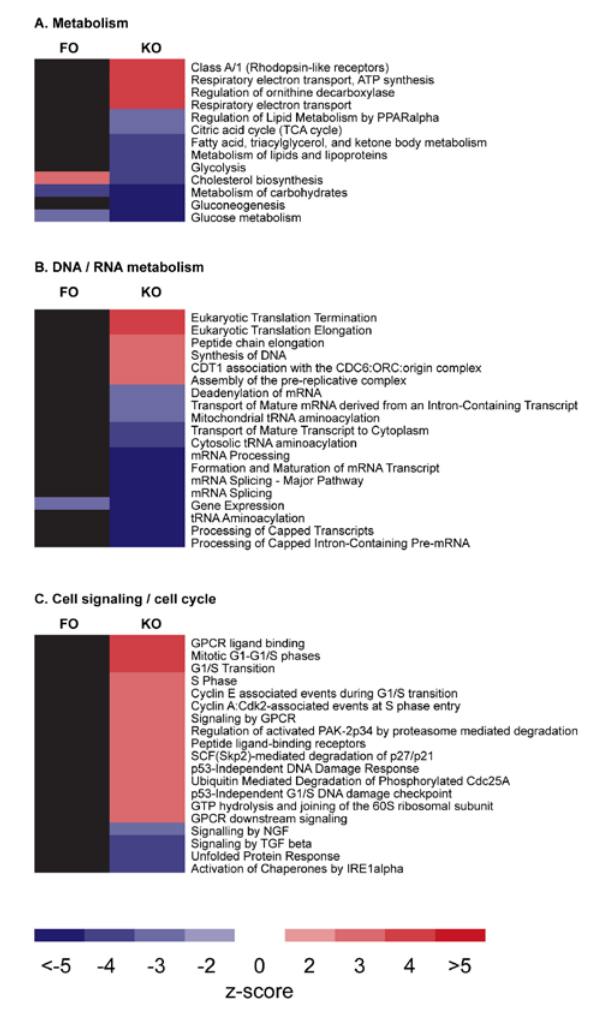
Figure 1. Identified hepatic metabolic pathways that are modulated after krill oil (KO) and fish oil (FO) feeding to mice. Each row indicates a separate pathway from the Reactome.org database. The first column indicates the effect of FO, the second one the effect of KO. Red cells are pathways that are significantly upregulated by treatment (either FO or KO). If the cell is blue, then the pathway was significantly downregulated by treatment (either FO or KO). A black fill indicates that the pathway activity was not changed by treatment. The figure was kindly contributed and adapted by J. Barger from [37] with permission of the